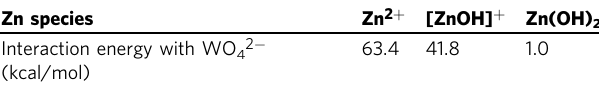
Table 1 Calculated interaction energy between Zn ion species (Zn 2 + , [ZnOH] + , Zn(OH) 2 ) and WO 4 2 − ions (cid:4) -- adsorbed on ZnO 10 10 plane in